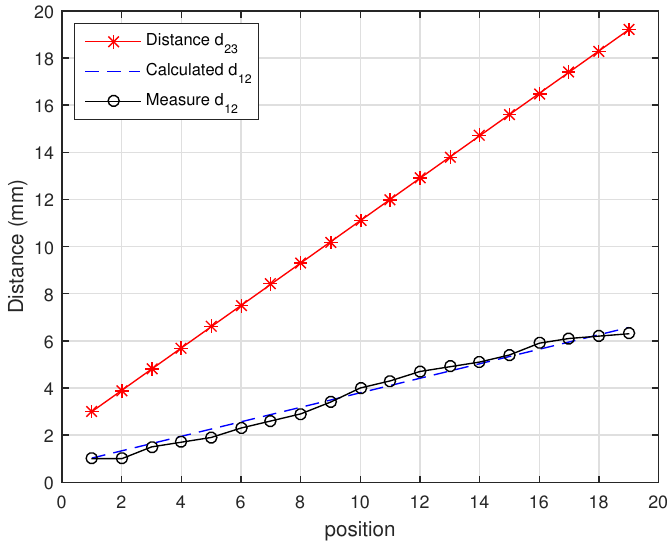
Figure 11. The relation between the distances d 12 and d 23 and a measured distance d 12